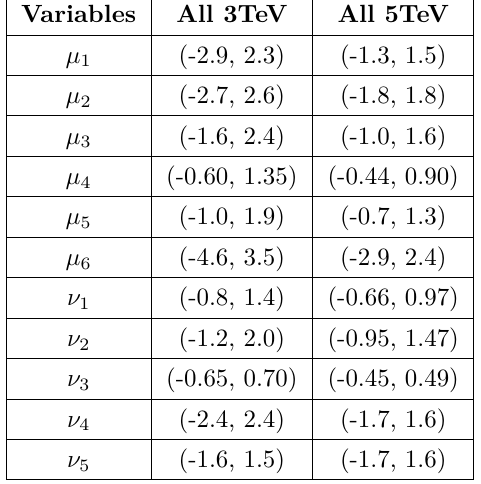
Table 7 . Allowed ranges for the quartic potential parameters from the global fit, at 95%